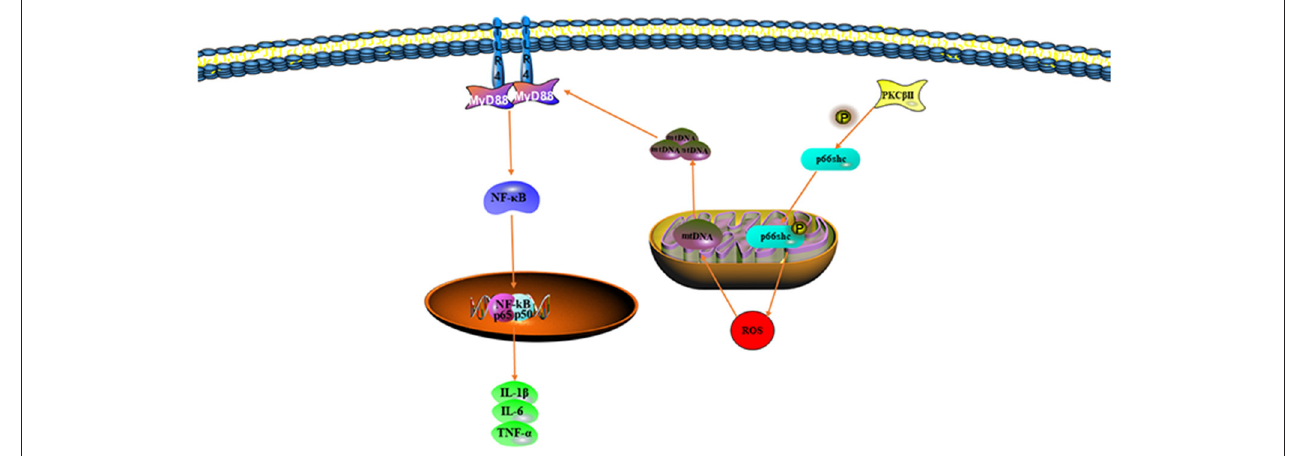
FIGURE 3 | Mitochondrial DNA (mtDNA) translocation aggravates oxidative